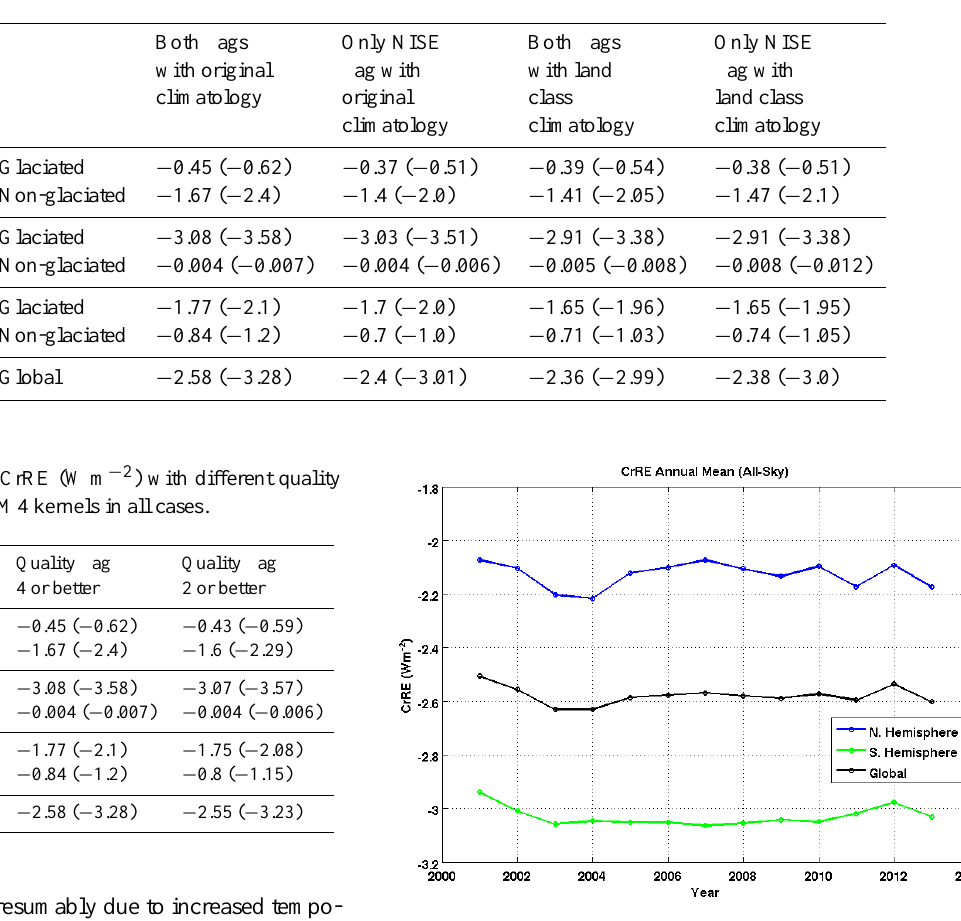
Figure 7. Annual-mean land LCrRE time series during 2001–2013 for the globe and each